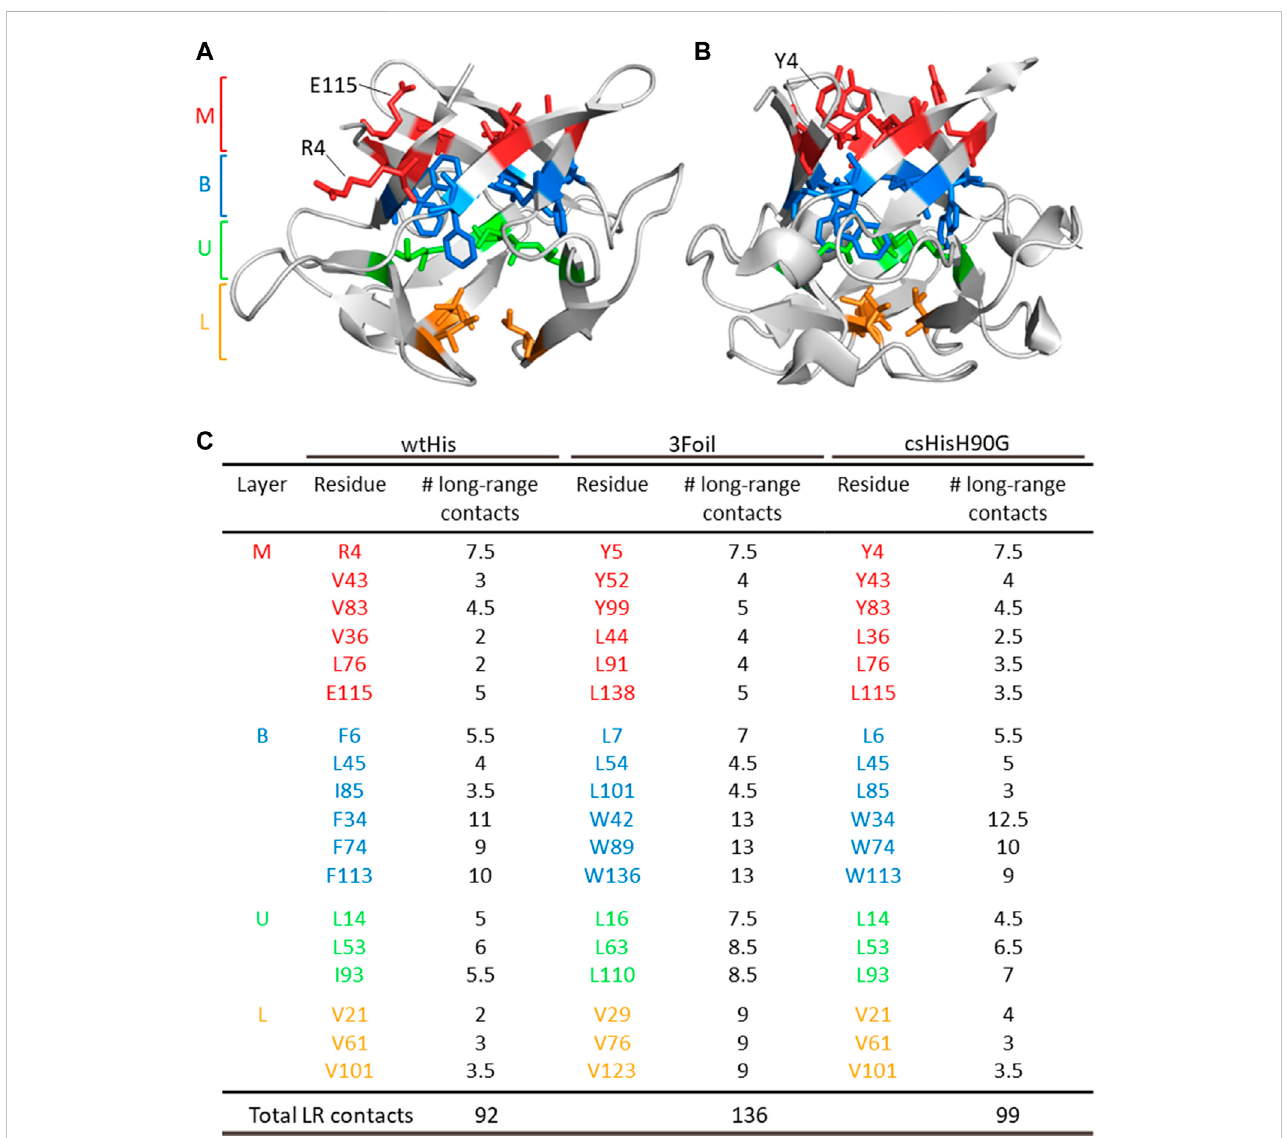
FIGURE 2 ThreeFoil core residues make signi fi cantly more long-range contacts than hisactophilin core residues. (A) Hisactophilin (wtHis) and (B) ThreeFoil (3Foil) conservedcoreresiduesarecoloredbylayer(Middlelayerofthe β -barrel,M;Bottomlayerofthe β -barrel,B;Upperlayerofthe β -hairpin,U;Lowerlayerofthe β -hairpin, L) according to their position in the β -trefoil fold (panel C) (Murzin et al., 1992). (C) Conserved core residues are listed for wtHis, 3Foil, and core- swapped hisactophilin (csHisH90G), where 11 of 18 hydrophobic residues differ between proteins. Mini-core residues were not considered during the design of csHisH90G and are not listed. Long-range contacts made between two core residues are counted as 0.5 long-range contacts per residue. The number of core residue long-range contacts is markedly higher in 3Foil relative to wtHis. Note that the speci fi c contacts made by a given residue may differ between proteins (e.g., wtHis R4, which points toward solvent (A) , makes different contacts than 3Foil Y5, which points into the protein core (B) ). Tryptophan residues used to monitor fl uorescence in 3Foil and csHisH90G are located in the B